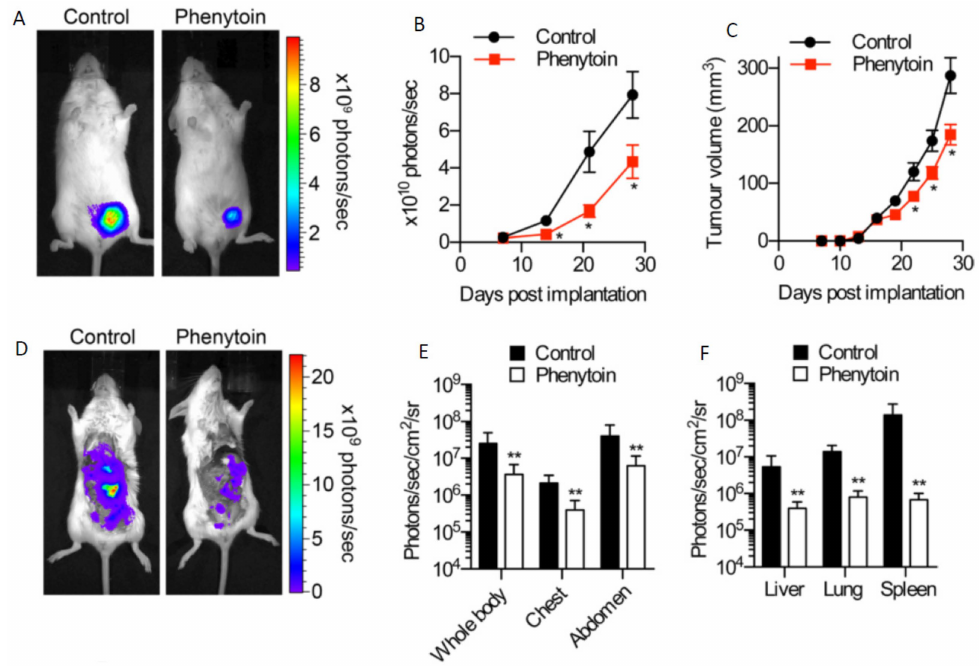
Figure 5. In vivo evidence showing suppression of breast cancer metastasis in a mouse (‘orthotopic’) model by blocking VGSC activity with phenytoin. ( A ) Bioluminescent images of control and phenytoin-treated mice, 4 weeks after implantation. ( B ) Bioluminescence measured from primary tumours on the indicated days post-implantation. Bioluminescence was quantified as indicated on the vertical axes. ( C ) Calculated volume derived from calliper measurement of primary tumours over the same period. ( D ) Bioluminescent images of metastases in control and phenytoin-treated mice. ( E ) Bioluminescence measured from the indicated anatomical sites. ( F ) Bioluminescence measured ex vivo from liver, lungs, and spleen. Data are means ± standard error of the means (SEMs). Asterisks (*’s) indicate statistically significant di ff erences (cf. corresponding controls). Modified from